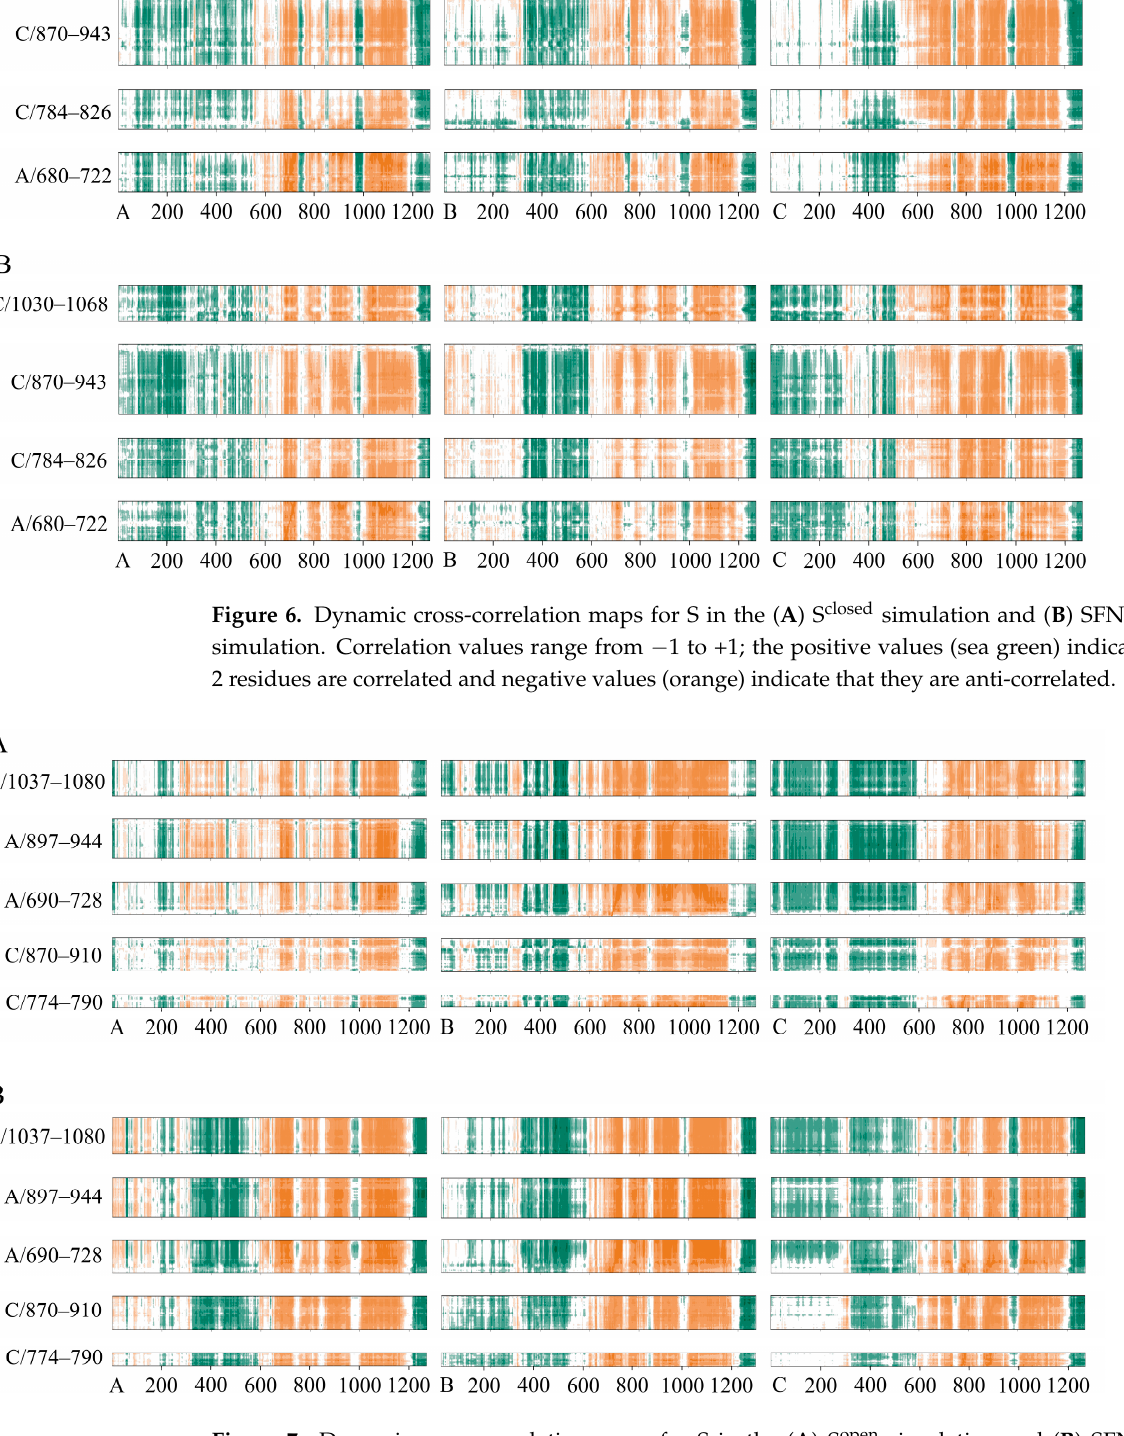
Figure 7. Dynamic cross-correlation maps for S in the ( A ) S open simulation and ( B ) SFN-S open simulation. Correlation values range from − 1 to +1; the positive values (sea green) indicate that 2 residues are correlated and negative values (orange) indicate that they are anti-correlated.